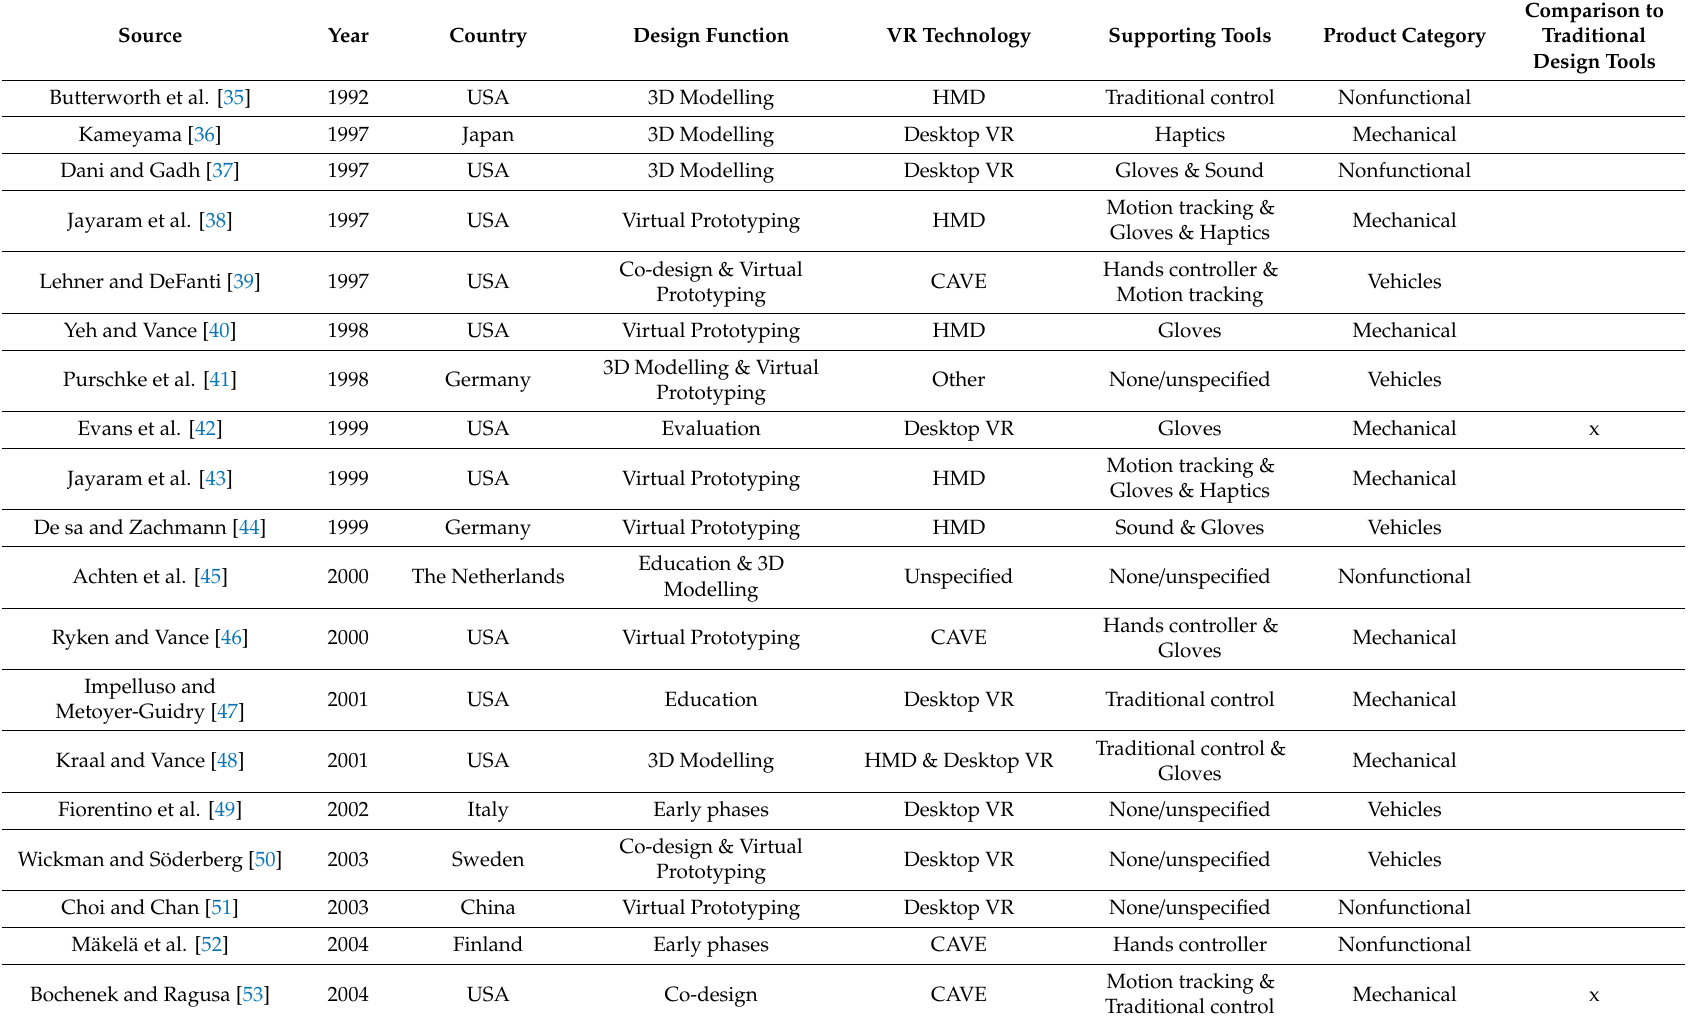
Table 6. Complete list of references illustrating VR applications in